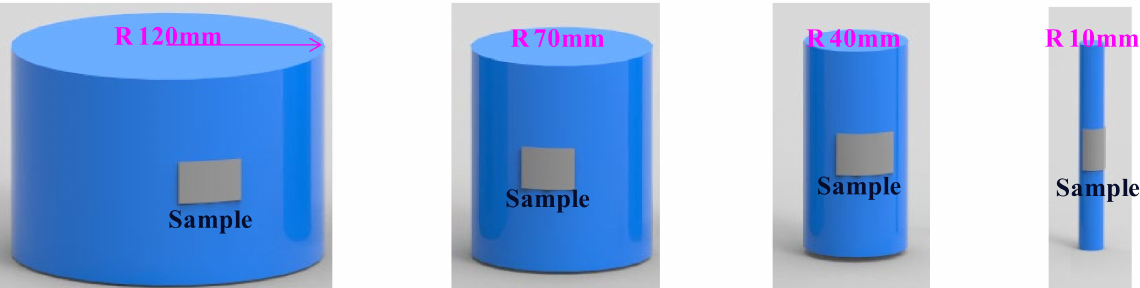
Figure 2. Schematic of Mo films bent to different curvature